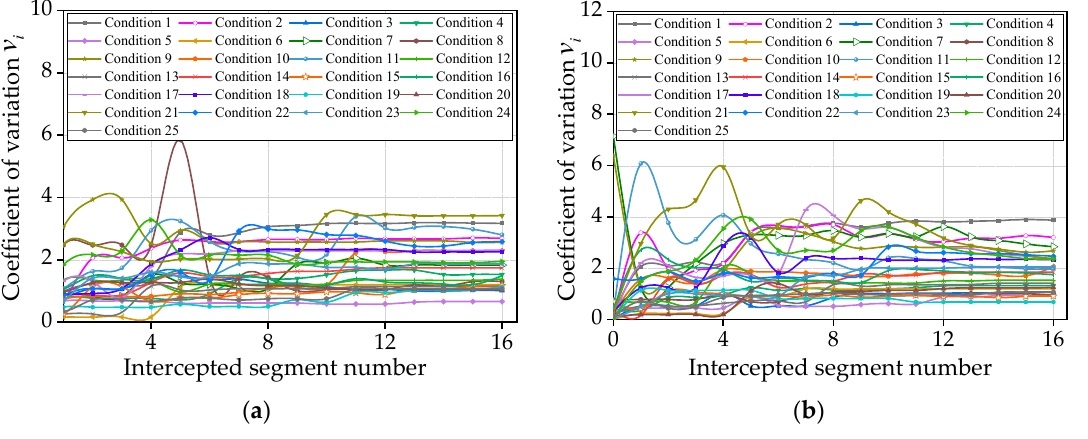
Figure 16. Coefficients of variation of the weighted DLA. ( a ) Coefficients of variation for two-span continuous gird bridge; ( b ) Coefficients of variation for three-span continuous gird bridge.